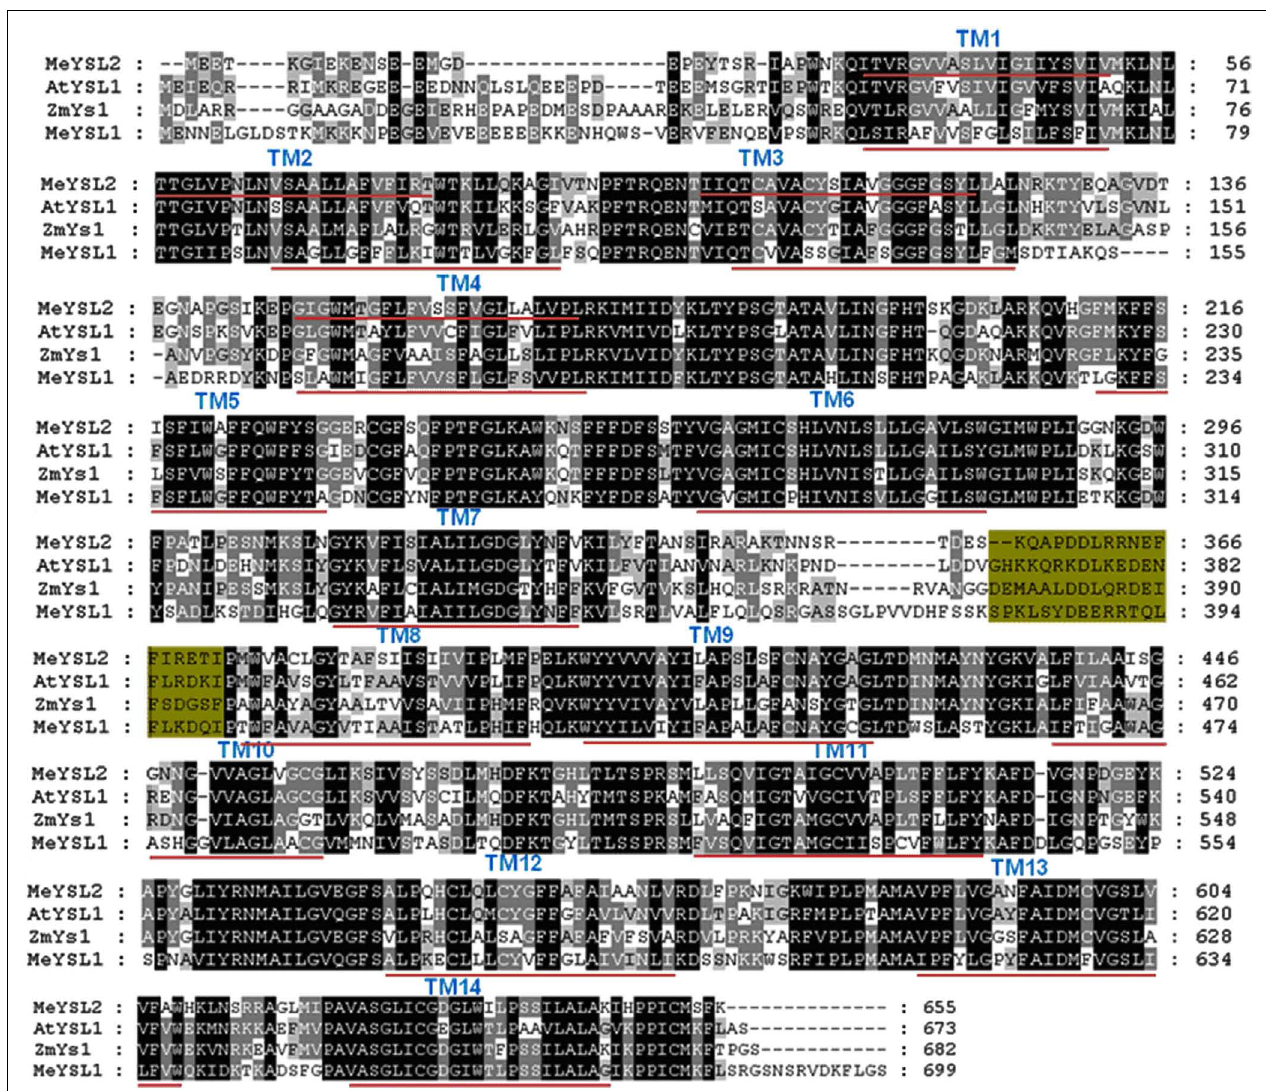
as red lines below the sequences. Green shaded sequences represent the sequence determining structural property and substrate specificity ofYS1/YSL transporters. Species designations are as follows: At, A. thaliana (AtYSL1); Zm, Zea Mays (ZmYS1); Me, Mannihot esculenta (MeYS1,